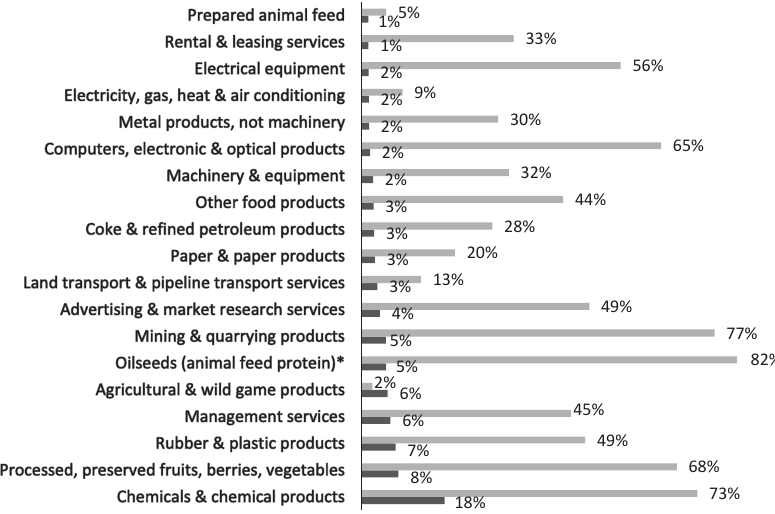
Fig. 5. Dairy products dependency on imports for the total supply of direct and indirect inputs into the sector *In the category of “Vegetable oils & animal